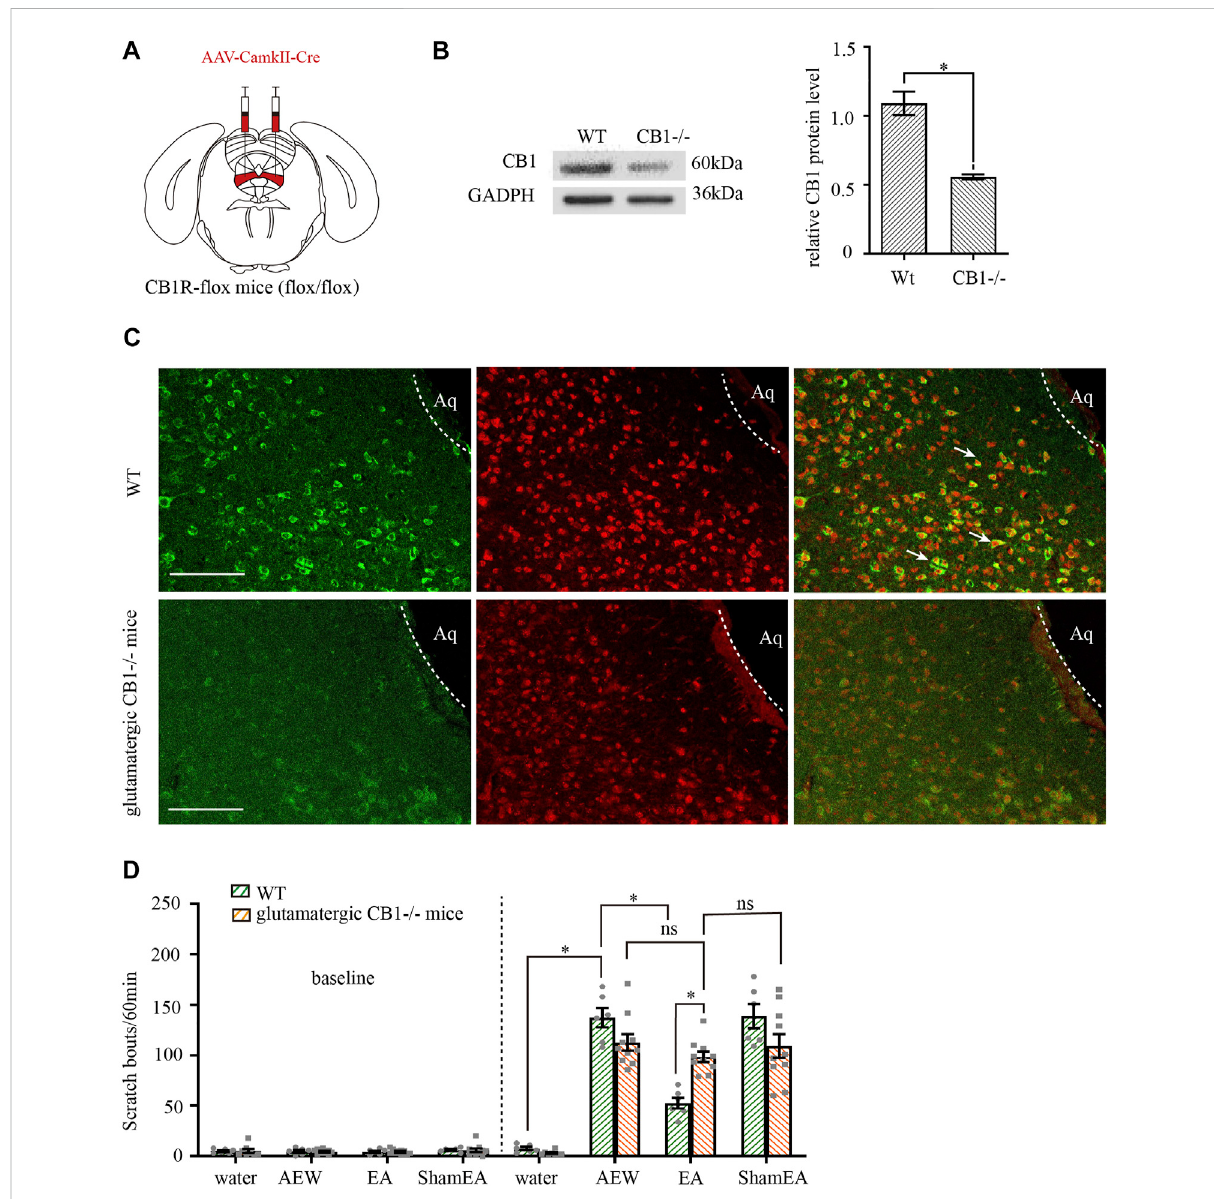
FIGURE 5 Comparison of the effects of EA on itch in control mice and glutamatergic -CB1 − / − mice. (A) Schematic showing viral targeting of AAV2/9- CamkII-Cre transgenes bilaterally injected into the vlPAG. (B) Representative gel image (left) and quanti fi cation (right) of the protein level of CB1 receptors in wild type mice and glutamatergic neurons -CB1 − / − mice. (C) Double staining of CB1 receptors (CB1R, green) and vglut2 mRNA (vglut2, red) of the vlPAG in wild-type mice and glutamatergic -CB1 − / − mice. (D) The comparison of scratch bouts in wild-type mice and glutamatergic -CB1 − / − mice. Scale bars: 100 μ m. Data are expressed as means ± SEM ( n = 10 mice in glutamatergic neurons -CB1 − / − mice, n = 6 mice in wild-type mice). * p <